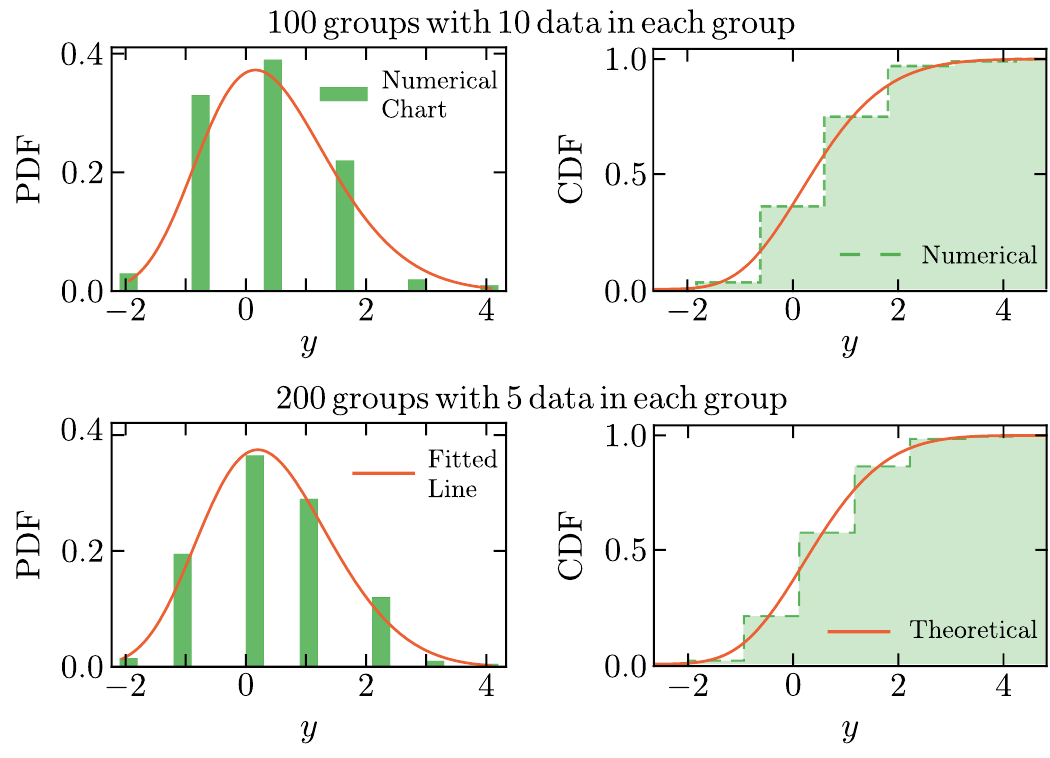
Figure 6 . Vortex-number GEV distribution for τ Q = 1000 . The numerical results follow the Weibull distribution with an upper